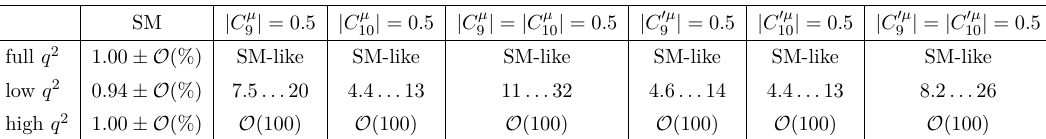
(4.2) in the SM and in NP-scenarios with couplings to muons for different q 2 -bins Table 2 . R Λ c p as in eq. (2.14). Ranges correspond to uncertainties from form factors and resonance parameters. Due to large uncertainties in the high- q 2 region, we only provide the order of magnitude for the largest